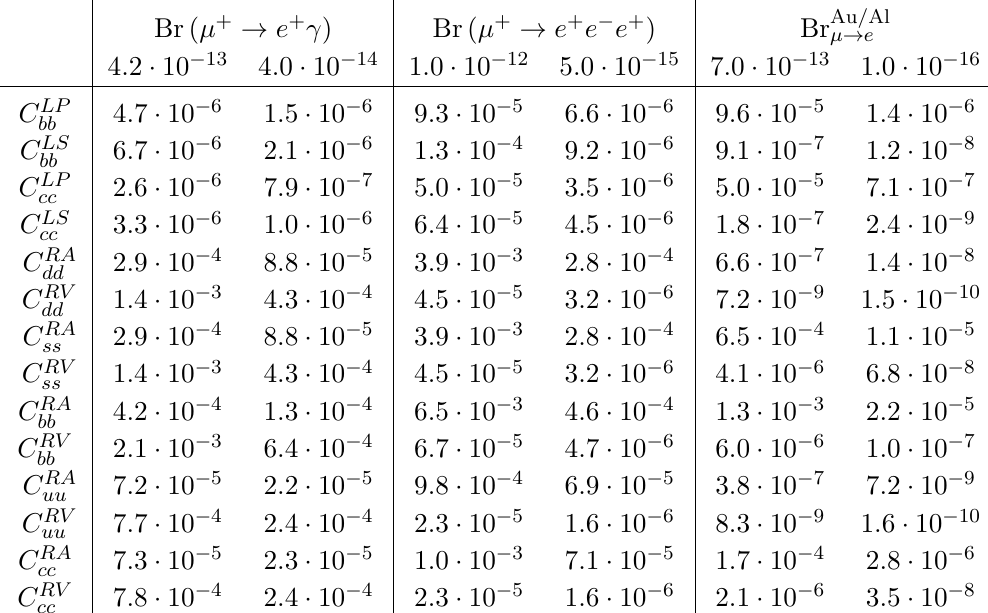
Table 4. Limits on the Wilson coe(cid:14)cients (given at the scale m W ) with scalar (vector) and pseudo- scalar (axial-vector) currents from current and future experimental constraints, assuming that only one coe(cid:14)cient at a time is non-vanishing at the high